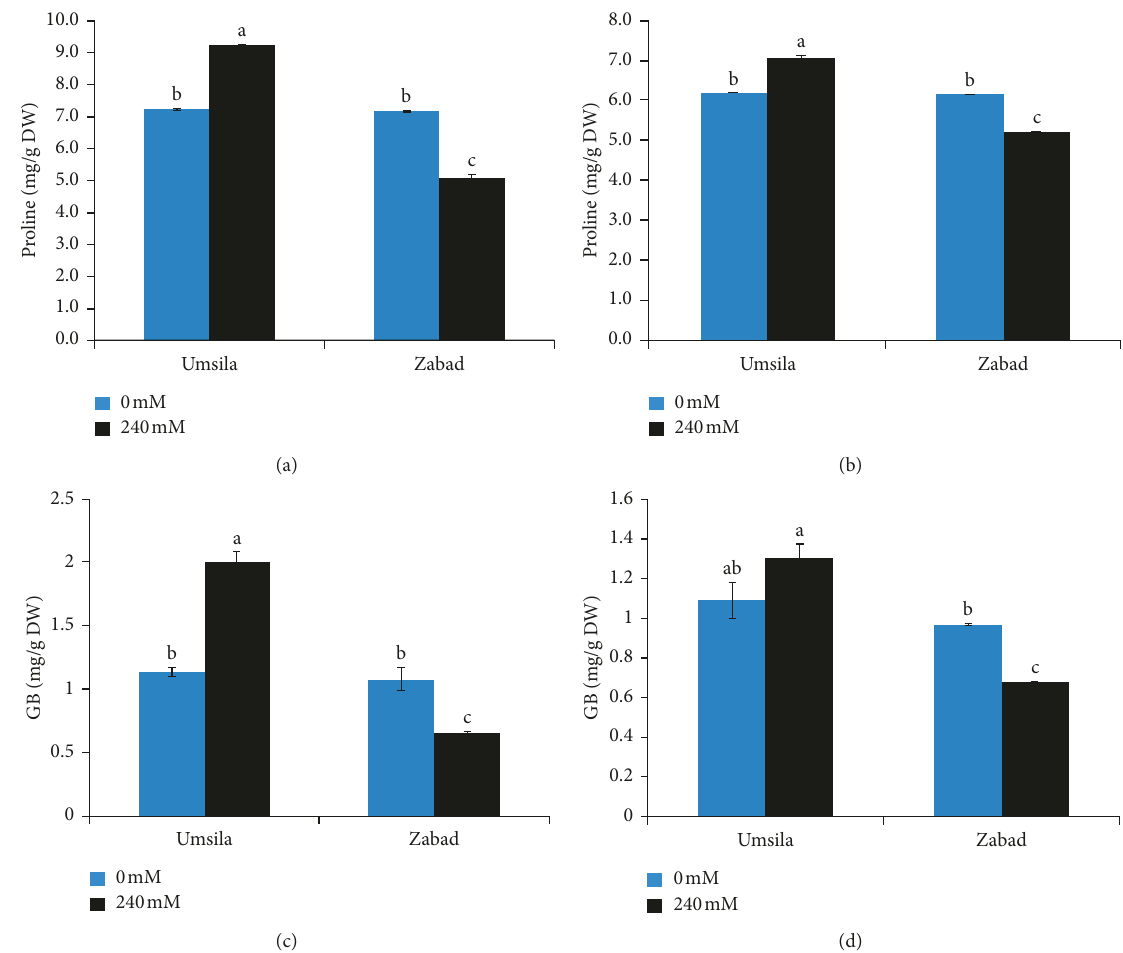
Figure 8: The effect of salinity on the accumulation of proline in leaves (a) and roots (b), and the accumulation of glycine betaine accumulation in leaves (c) and in roots (d) of date palm seedlings when exposed to control (0mM NaCl) and salinity (240mM NaCl) conditions. Bars represent the mean ± SE ( n � 3). Statistical differences between the treatments were calculated based on p ≤ 0 . 05.